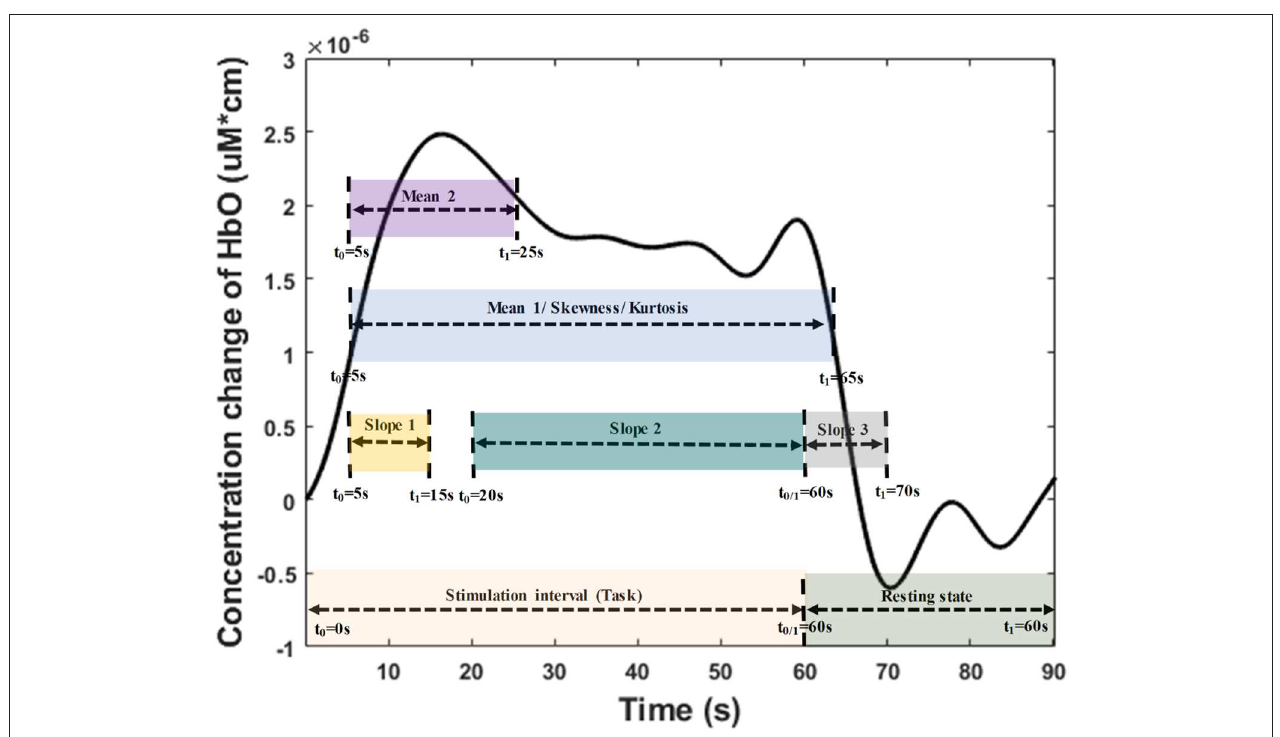
FIGURE 5 | Time interval distribution of the temporal features (i.e., mean, slope, skewness, and kurtosis) for temporal-spatial neural images